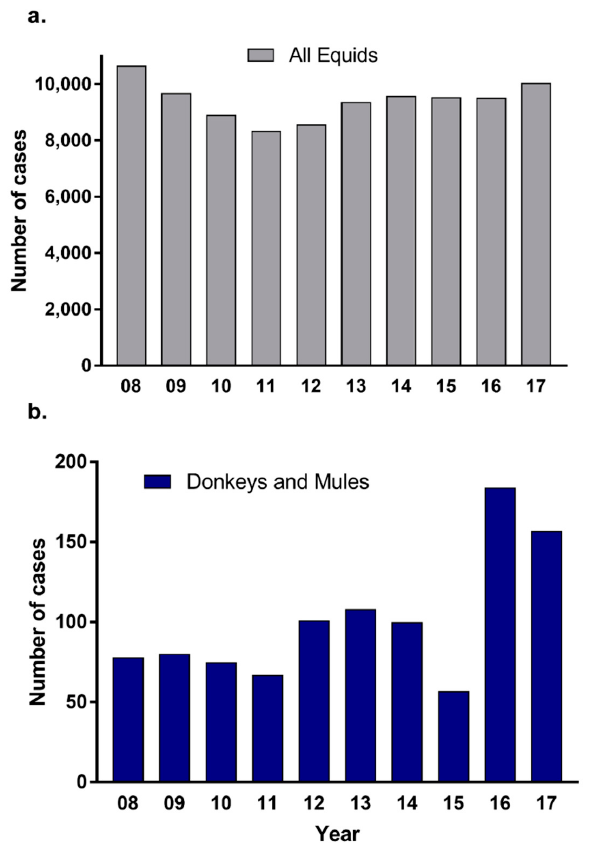
Figure 1. Distribution of the Visits of Equids for Each Year from 2008 to 2017. The yearly caseload for: ( a ) all equids (grey), and ( b ) donkeys and mules combined (blue). The caseload of donkeys and mules at the UC Davis Veterinary Medical Teaching Hospital (VMTH) over a 10-year period of 1.06% of the total equid caseload is proportionally slightly higher than the overall estimated proportion of donkey and mule populations in the United States (Table S1). Most visits were donkeys (0.61%) as compared to mules (0.45%), which is congruent with the estimated distribution within the United States.